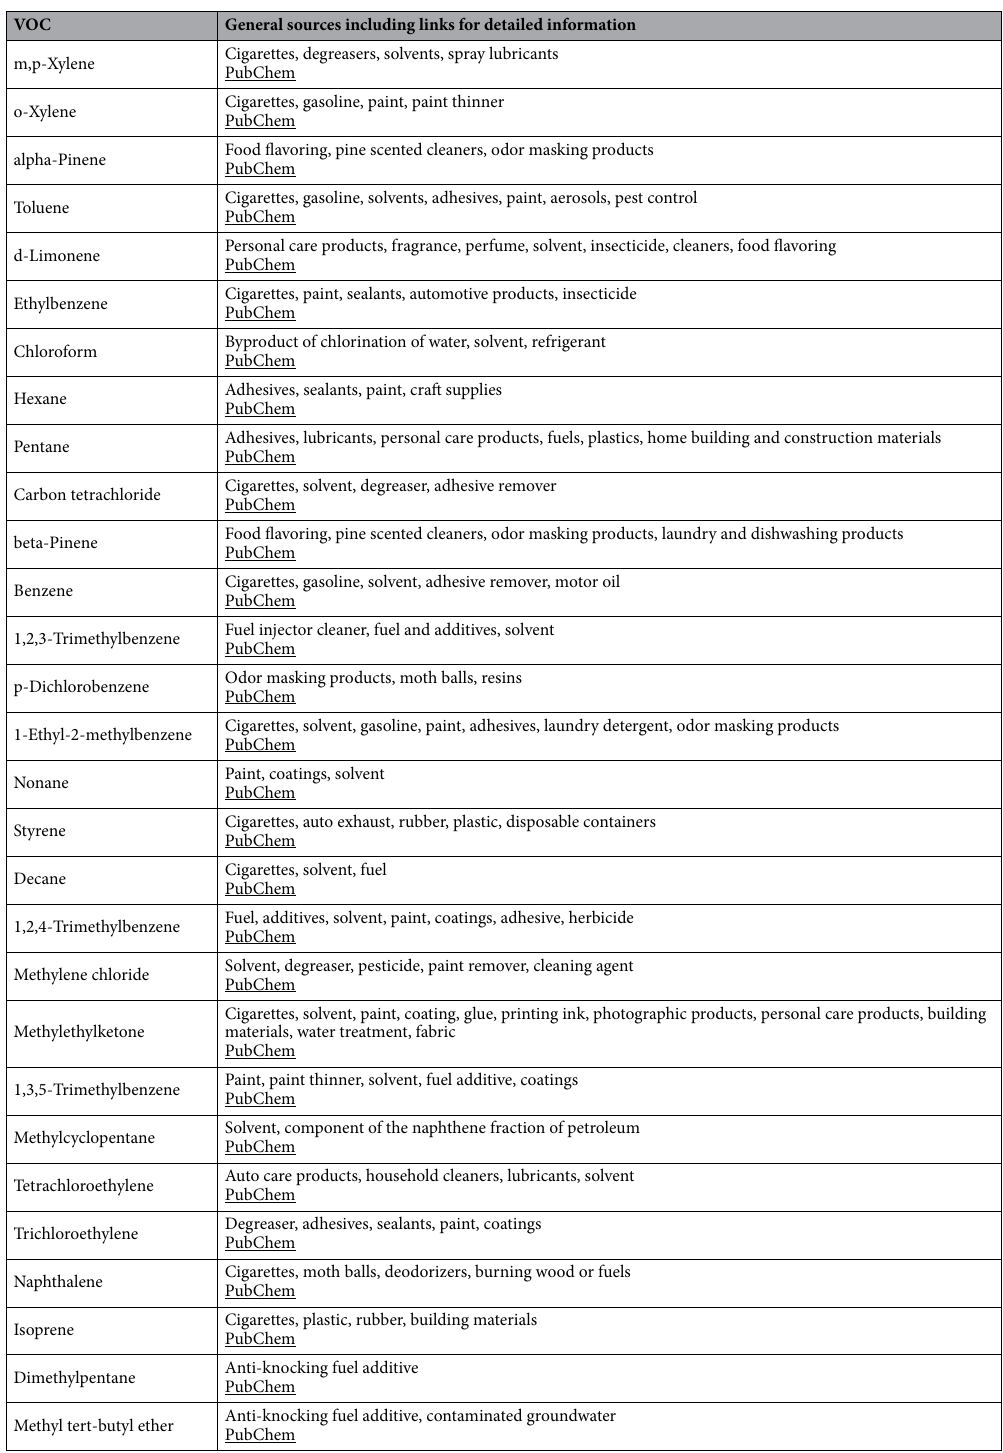
Table 1. Targeted volatile organic compounds (VOCs) in residential air sampling in southeast Louisiana. Information including general source(s) are provided as well as products that VOCs are found in and toxicological information regarding each VOC where available. Items without active hyperlinks do not have information available at this time (accessed